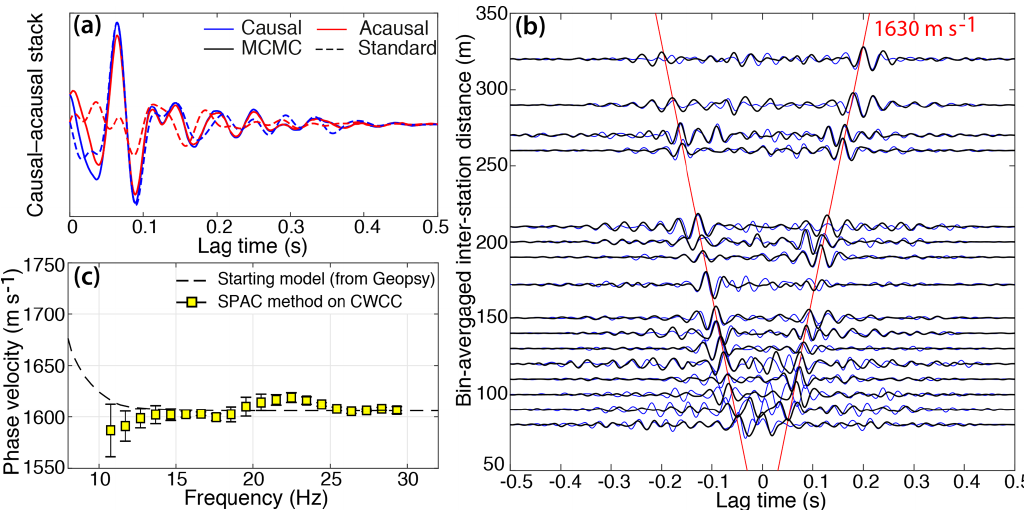
Figure 11. (a) Causal–acausal symmetry of the CWCC obtained at one station pair using standard coda interferometry processing as in Fig. 10d (dashed lines) and MCMC processing (solid lines). (b) Correlation gather sorted by increasing distance and averaged in 10m intervals. Black and blue lines result from MCMC and standard processing, respectively. Red lines show the propagation of Rayleigh waves with the velocity of 1630ms − 1 . (c) Rayleigh wave phase velocity dispersion curve (yellow squares) averaged over measurements for all station pairs. Error bars indicate discrepancies in velocity measurements at different station paths. The dispersion curve is obtained with the Aki’s spectral method. The dashed black line is the theoretical dispersion curve for a 160m thick ice layer computed with